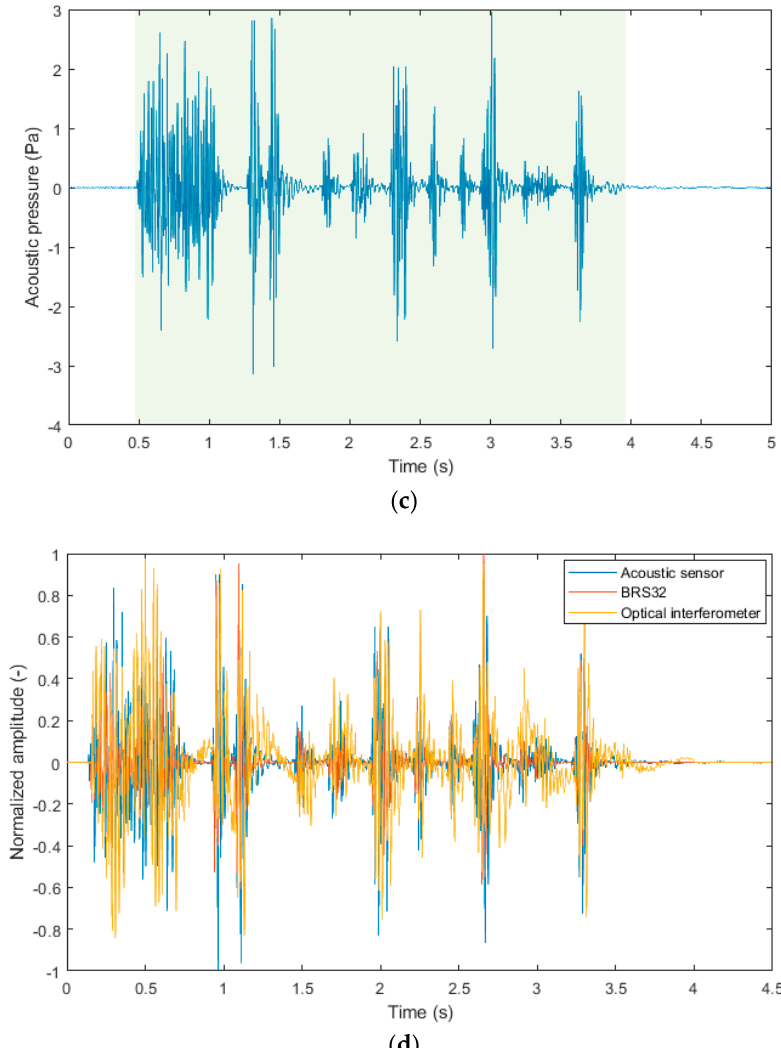
Figure 12. The waveform images from the blasting operation recording of 11 March 2019: ( a ) Seismic apparatus BRS32; ( b ) interferometric sensor; ( c ) acoustic sensor; ( d ) graphical comparison of the three records described above in one graph.